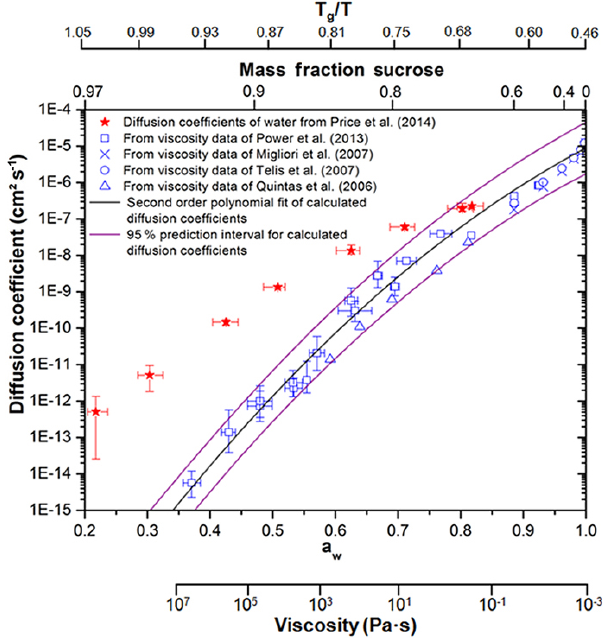
Figure 8. A comparison of measured diffusion coefficients of wa- ter in sucrose–water films from Price et al. (2014) (red stars) with predicted diffusion coefficients based on measured viscosi- ties of sucrose–water solutions and the Stokes–Einstein equation from Power et al. (2013) (blue squares) Migliori et al. (2007) (blue crosses), Telis et al. (2007) (blue circles) and Quintas et al. (2006) (blue triangles). Several different x axes (wt% sucrose, a w , T g /T and viscosity) are included to help put the results in context. T repre- sents the temperature of the experiment (294.5K), and T g represents the glass transition temperature of sucrose–water